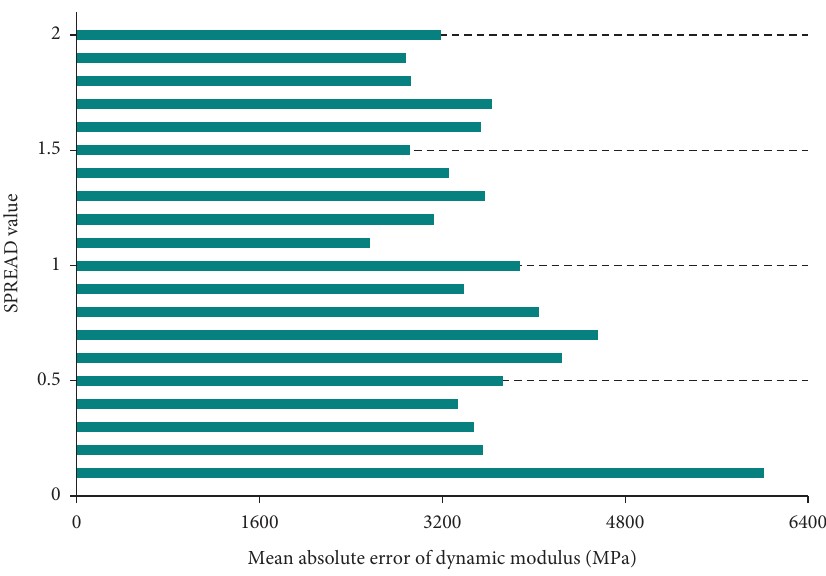
Figure 3: Optimal spreading